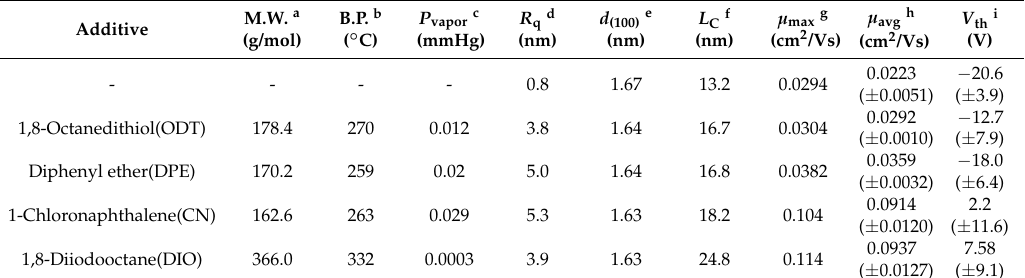
Table 1. Properties of processing additives, morphological parameters of P3HT thin films, and electrical parameters of thermally annealed P3HT OFETs.